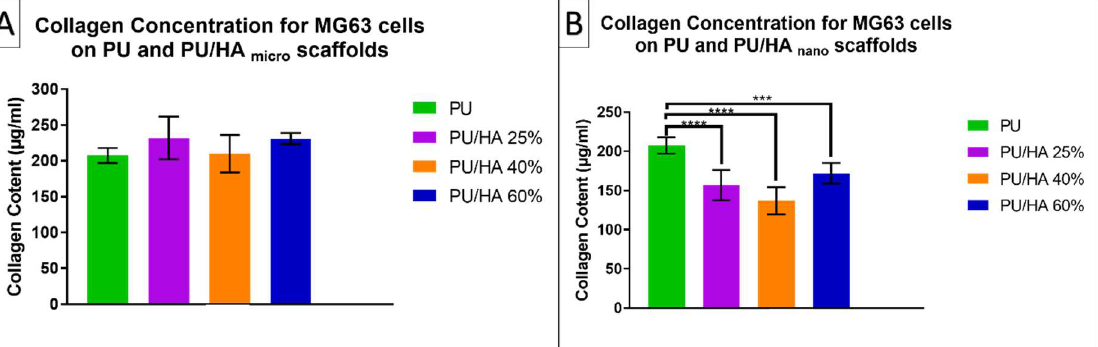
Figure 11. Collagen matrix production; ( A ) for PU/HA micro group & ( B ) for PU/HA nano group scaffolds on days 28 of culture. PU scaffold has higher than PU/HA nano scaffolds significantly, where no significant difference with PU/HA micro. Differences between two groups were distinguished as statistically significant if p ≤ 0.001 (***) and p ≤ 0.0001 (****).